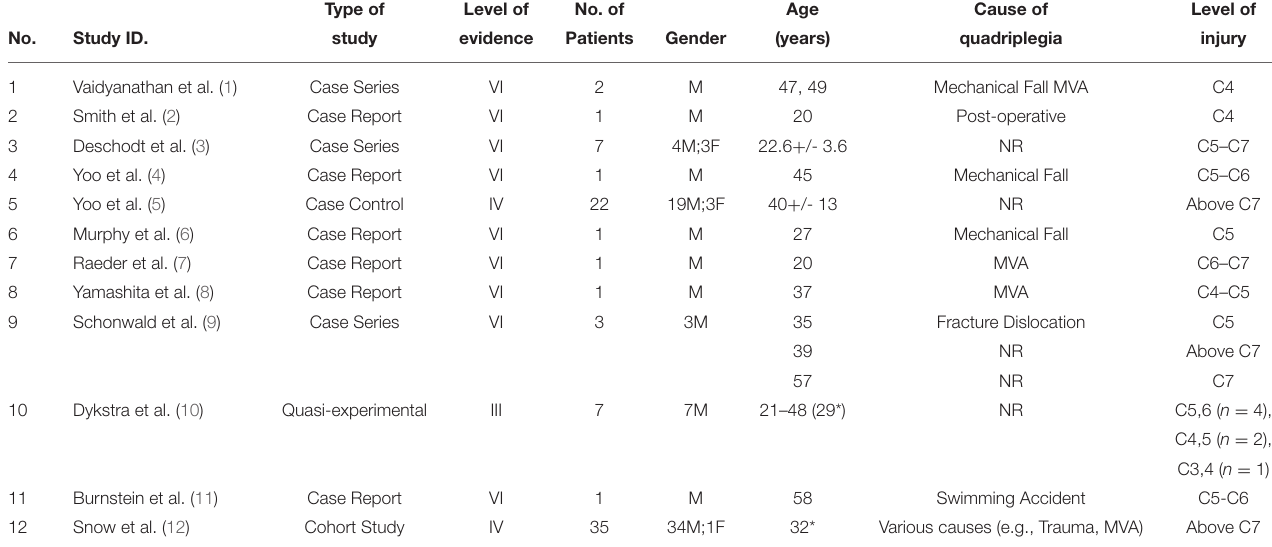
TABLE 1 | Studies and demographical